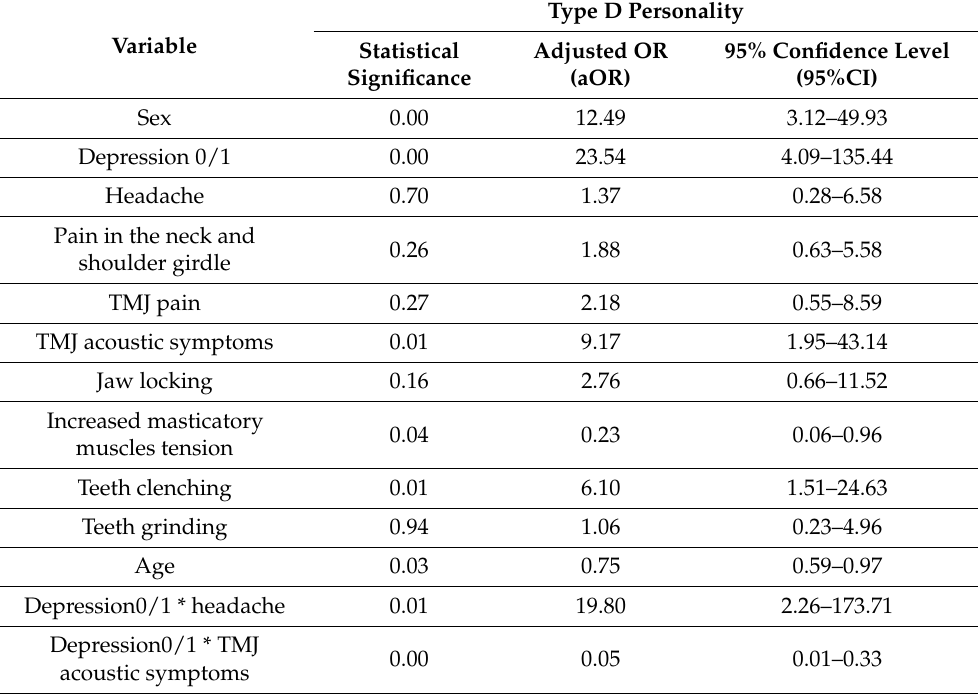
Table 5. Logistic regression model for the occurrence of a type D personality, including depression. * the interaction effect between “x” and